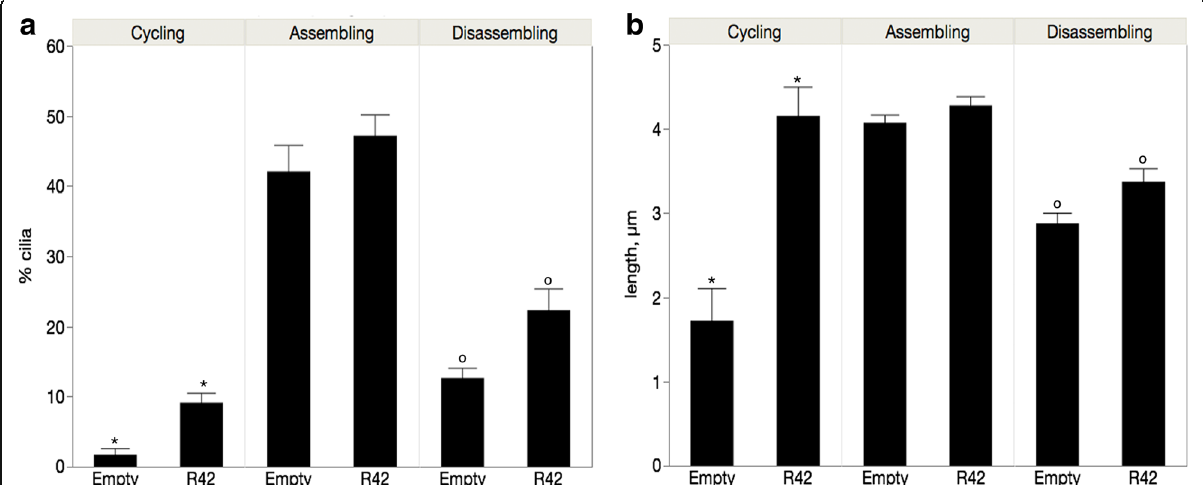
Fig. 6 PPP1R42 overexpression induces an increase in cilia number and length. ARPE-19 cells were transfected with expression vector containing FLAG-tagged PPP1R42 (R42), grown for 24 h (cycling, left panel), induced to assemble cilia by removal of serum for 48 h (assembling, middle panel) followed by reintroduction of serum to cause cilia to disassemble (disassembling, right panel). Cilia number ( a ) and length ( b ) were measured at each condition. Transfection with empty vector was the negative control. A total of 300 cells were counted and significant differences are indicated with matching symbols; p ≤ 0.05. The means for cilia number and length ± SEM are shown in Table